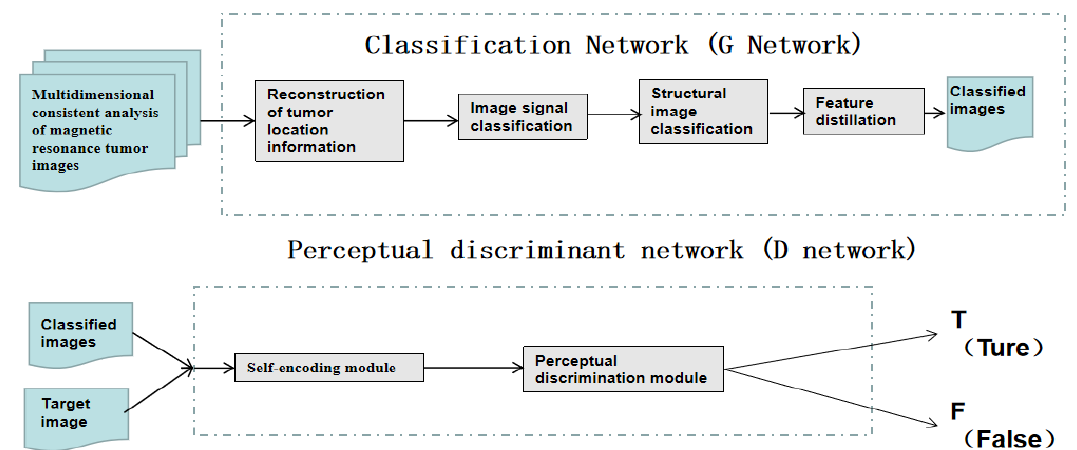
Figure 9. Schematic diagram for constructing a multi-dimensional MRI enhancement framework based on generated confrontation learning, which is proposed.